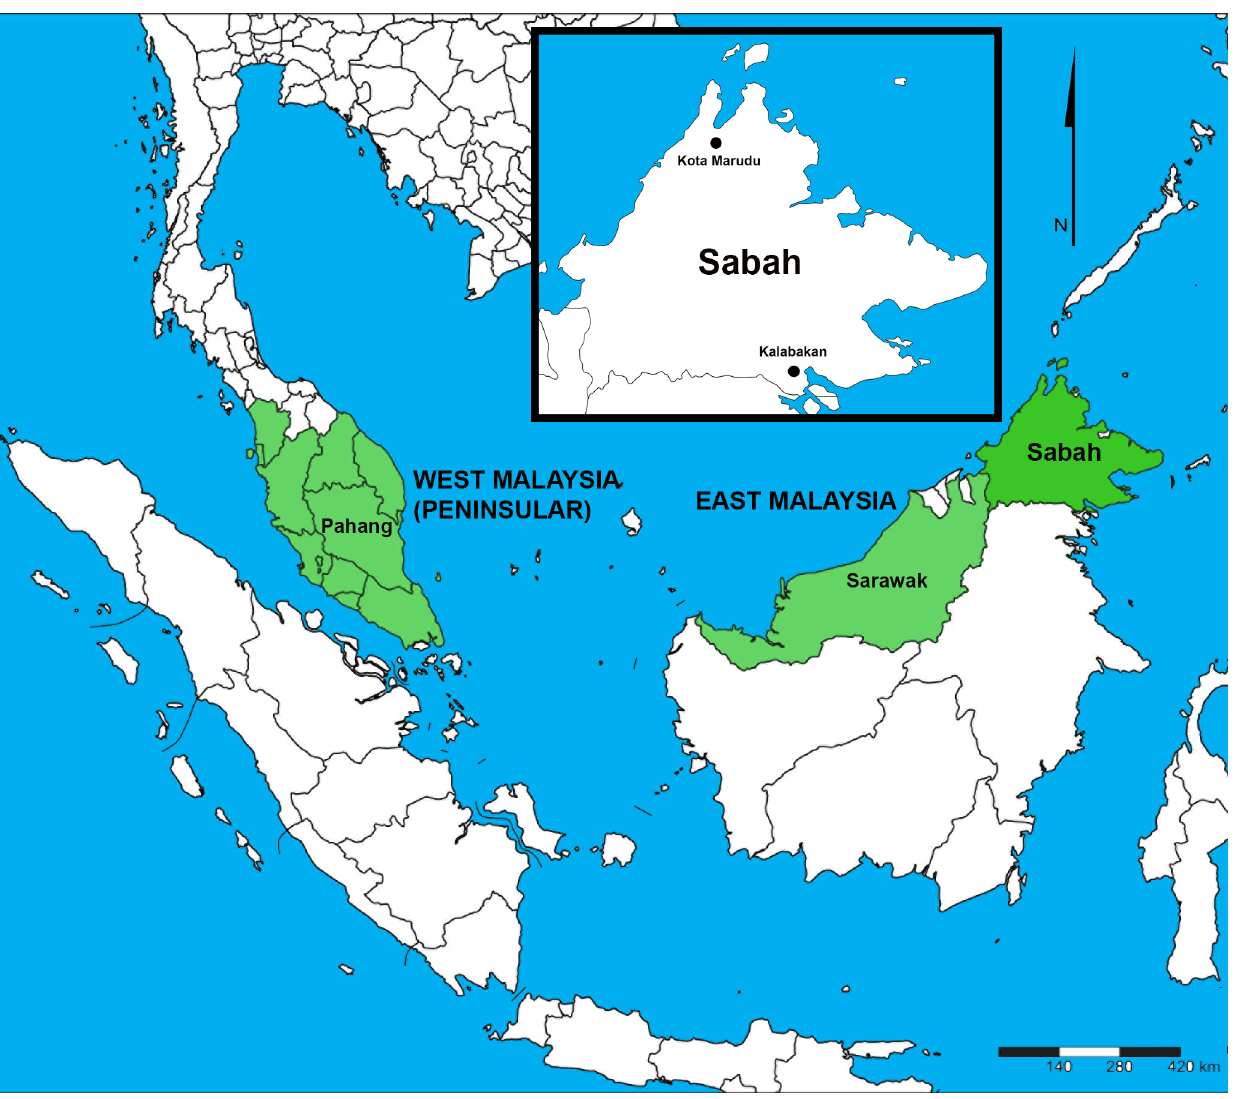
Parasite genomic DNA was extracted from blood – spotted filter papers by using QIAmp 1